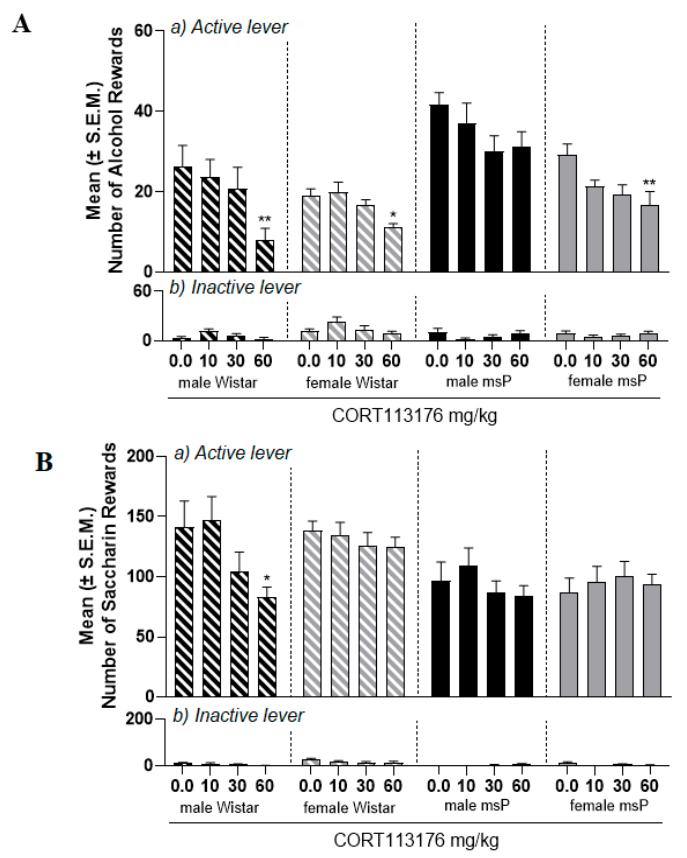
Figure 2. Effect of CORT113176 on alcohol and saccharin self-administration in male and female msP and Wistar rats. Male and female msP and Wistar rats were treated with CORT113176 (0.0, 10, 30 and 60 mg/kg) i.p., 90 min prior to test session. ( A ) CORT113176 treatment significantly reduced the number of alcohol rewards in male and female Wistars and in female msP rats. ( B ) CORT113176 at the dose of 60 mg/kg significantly reduced saccharin SA in male Wistar rats only. Data are expressed as the mean ± SEM of number of: ( a ) reinforced responses at the active and ( b ) total responses at inactive lever. Significant difference from vehicle (0.0 mg/kg): ** p < 0.01; * p < 0.05.